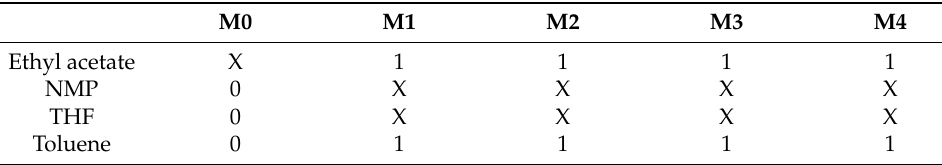
Table 2. Qualitative observation of the solvent stability of the reference membrane (M0) and UV-cured PSf membranes